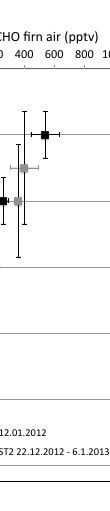
Figure 5. Vertical profiles of HCHO in interstitial air at Concordia. Vertical bars refer to the depth from which 66% of air was sam- pled (see Sect. 2.3) and the horizontal ones to standard deviations of 10min and 30s means for 2012/13 and 2011/12,